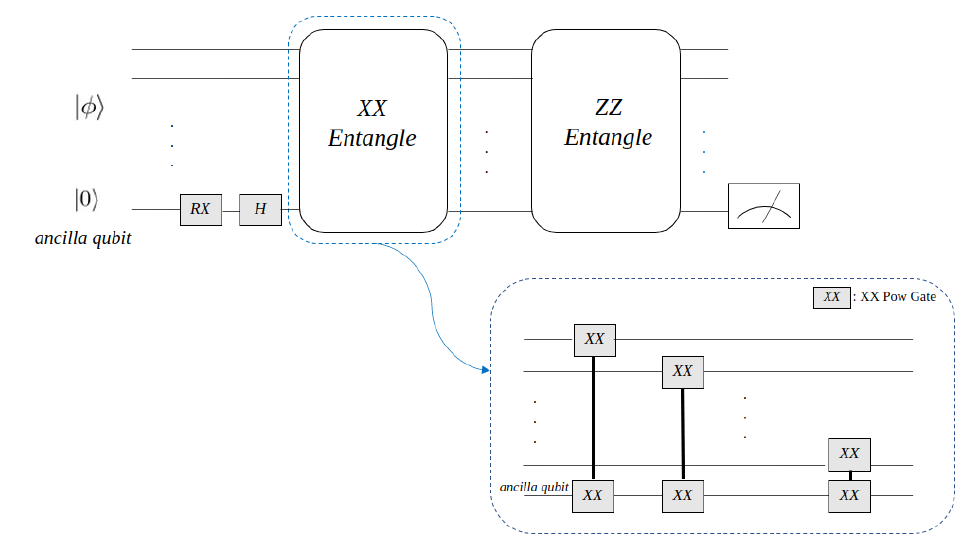
Figure 2. The design of baseline QNN [8].